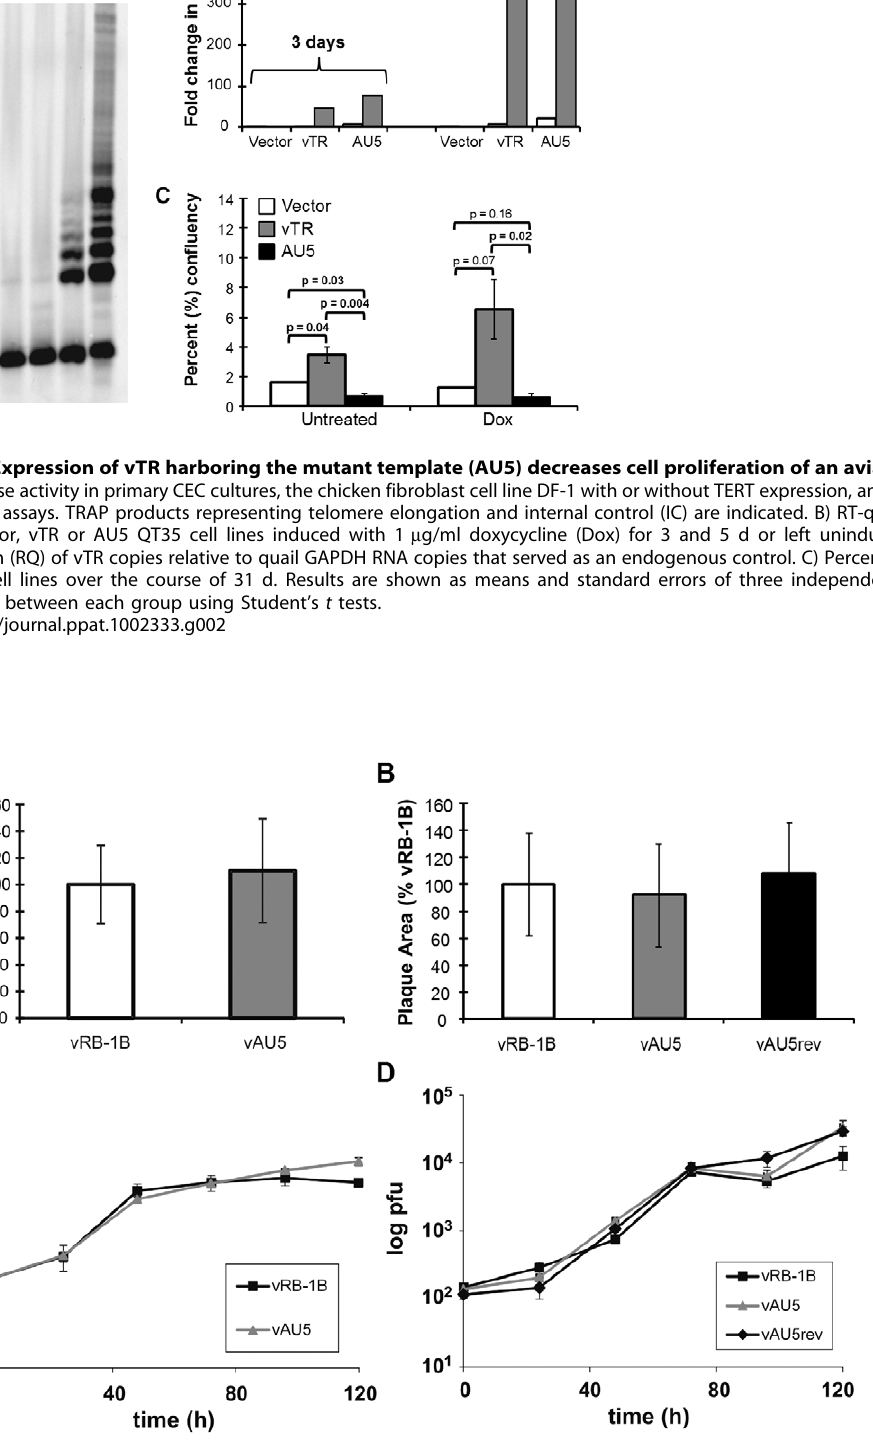
Figure 3. MDV harboring a template mutant vTR replicate comparable to parental and revertant viruses invitro . A–B) Plaque areas were determined for 35 (A) or 100 (B) randomly selected plaques for indicated viruses. Results are shown as mean plaque areas in percent of the parental vRB-1B with standard deviations (error bars). C–D) Multi-step growth kinetics of indicated viruses were performed in triplicates and are shown as means with standard deviations (error bars).